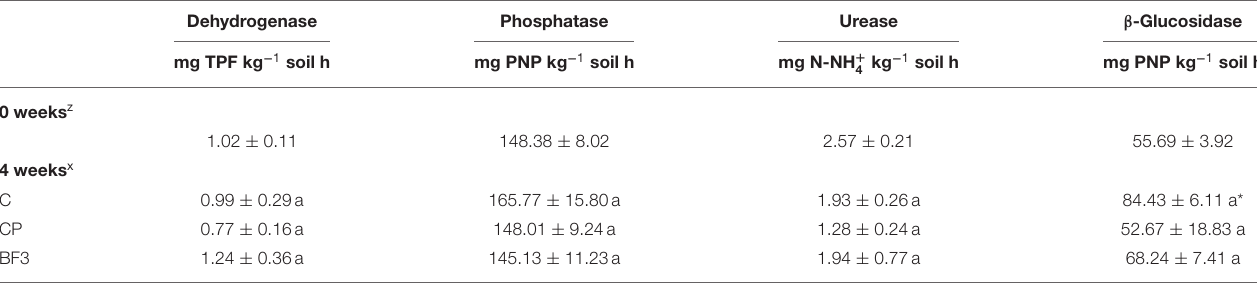
TABLE 2 | Soil enzyme activities before Brassica carinata pellets incorporation (0 weeks) and at the end of the treatments in the field experiment (4 weeks).